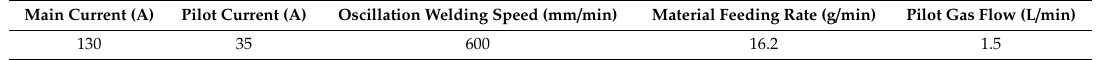
Table 2. Processing parameters of plasma metal deposition (PMD)